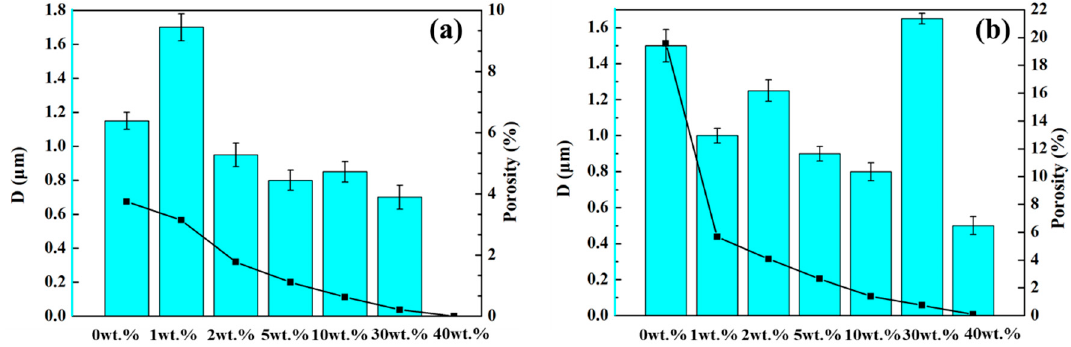
Figure 3. The variation of pore diameter (histograms) and porosities (curves) with different acetone content of all samples after curing and pyrolyzing. ( a ) Samples after curing and ( b ) samples after pyrolyzing.